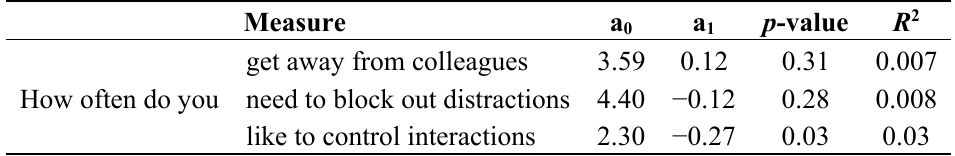
Table 6. Summary of regression model between the number of days in the office and the need to carry out privacy behaviours, a 0 is the model intercept; a 1 is the model gradient.